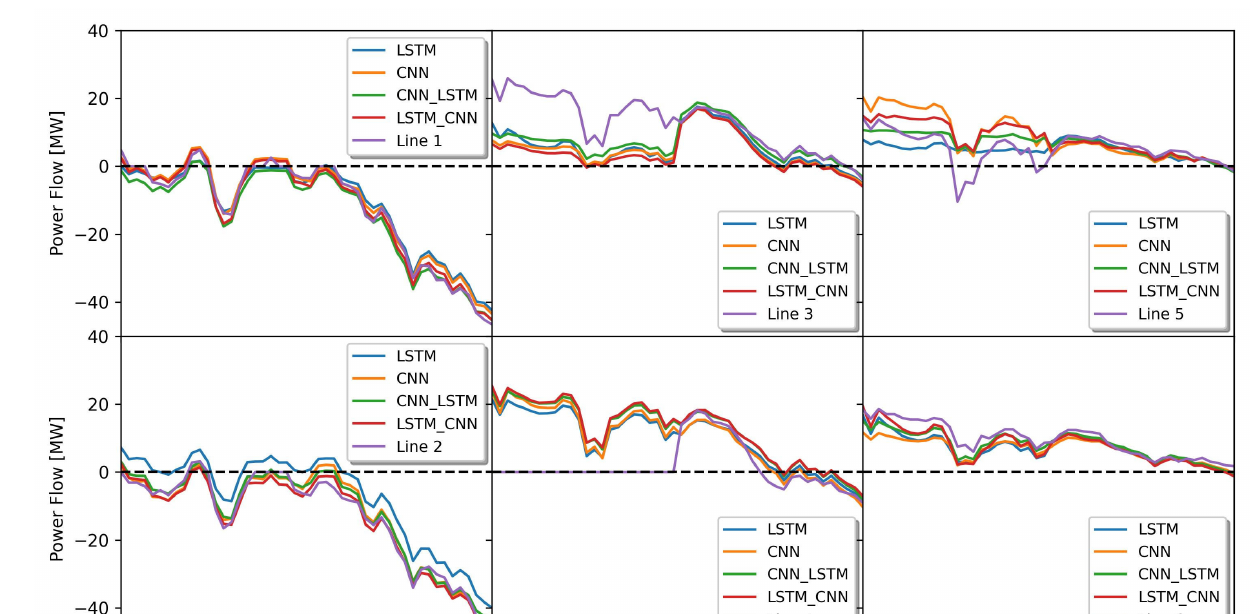
Figure 9. Training duration time of all the deep learning models.